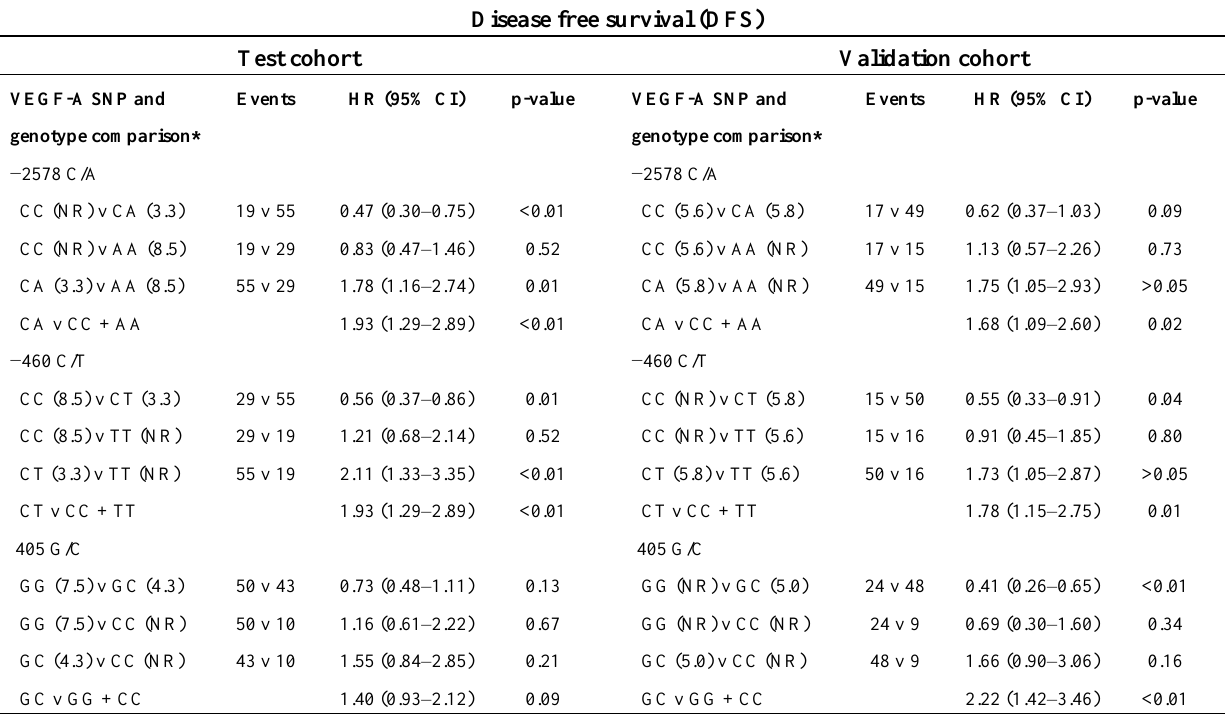
Table 2. Relationship between SNP status and survival in both cohorts. All patients are included. Disease free survival